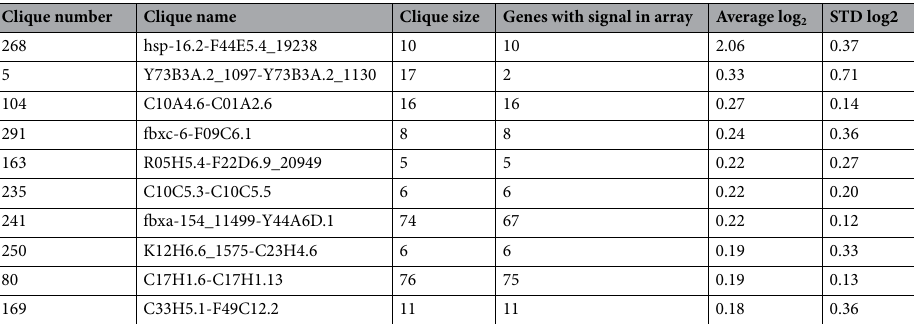
Table 1. Cliques identified as significantly up- or downregulated in the heat-shock experiments of Wang et al. (GSE2862) 31 . The average values for the three replicate experiments are shown together with the standard deviation and the clique